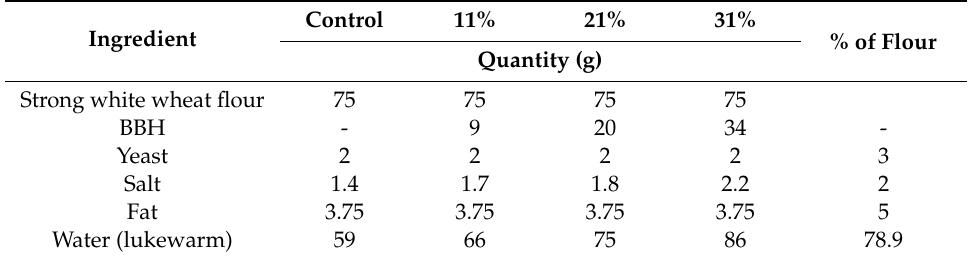
Table 1. Formulations for control and broad bean hull (BBH) enriched